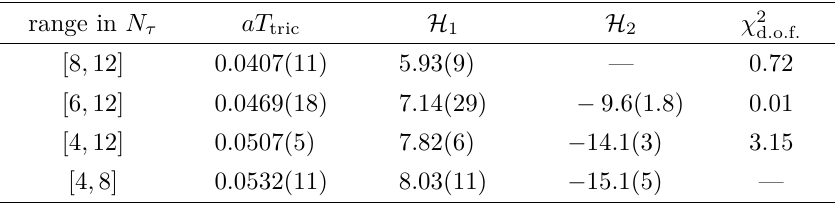
Table 5. Fits of the data in figure 12 to eq.